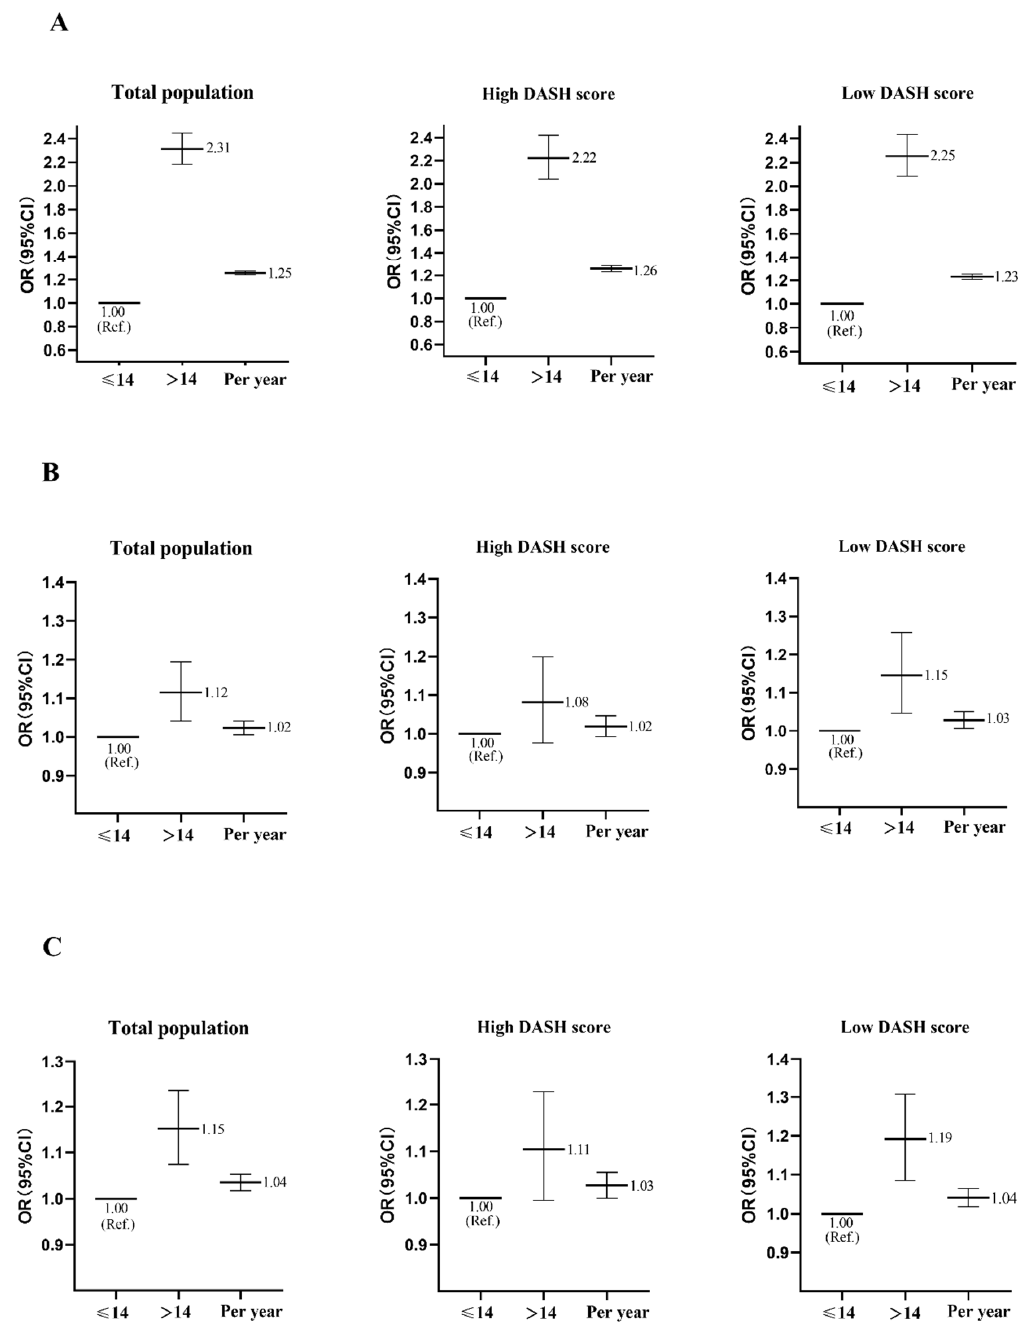
Figure 2. Odds ratio (OR) and 95% CI for hypertension according to binary categories (AM > 14 years vs. AM ≤ 14 years) or per year increase in AM among individuals in the total population and high and low DASH score groups. ( A ) Results using the crude model regression analyses. ( B ) Results using model 1 regression analyses. ( C ) Results using model 2 regression analyses. Ref. indicates the reference